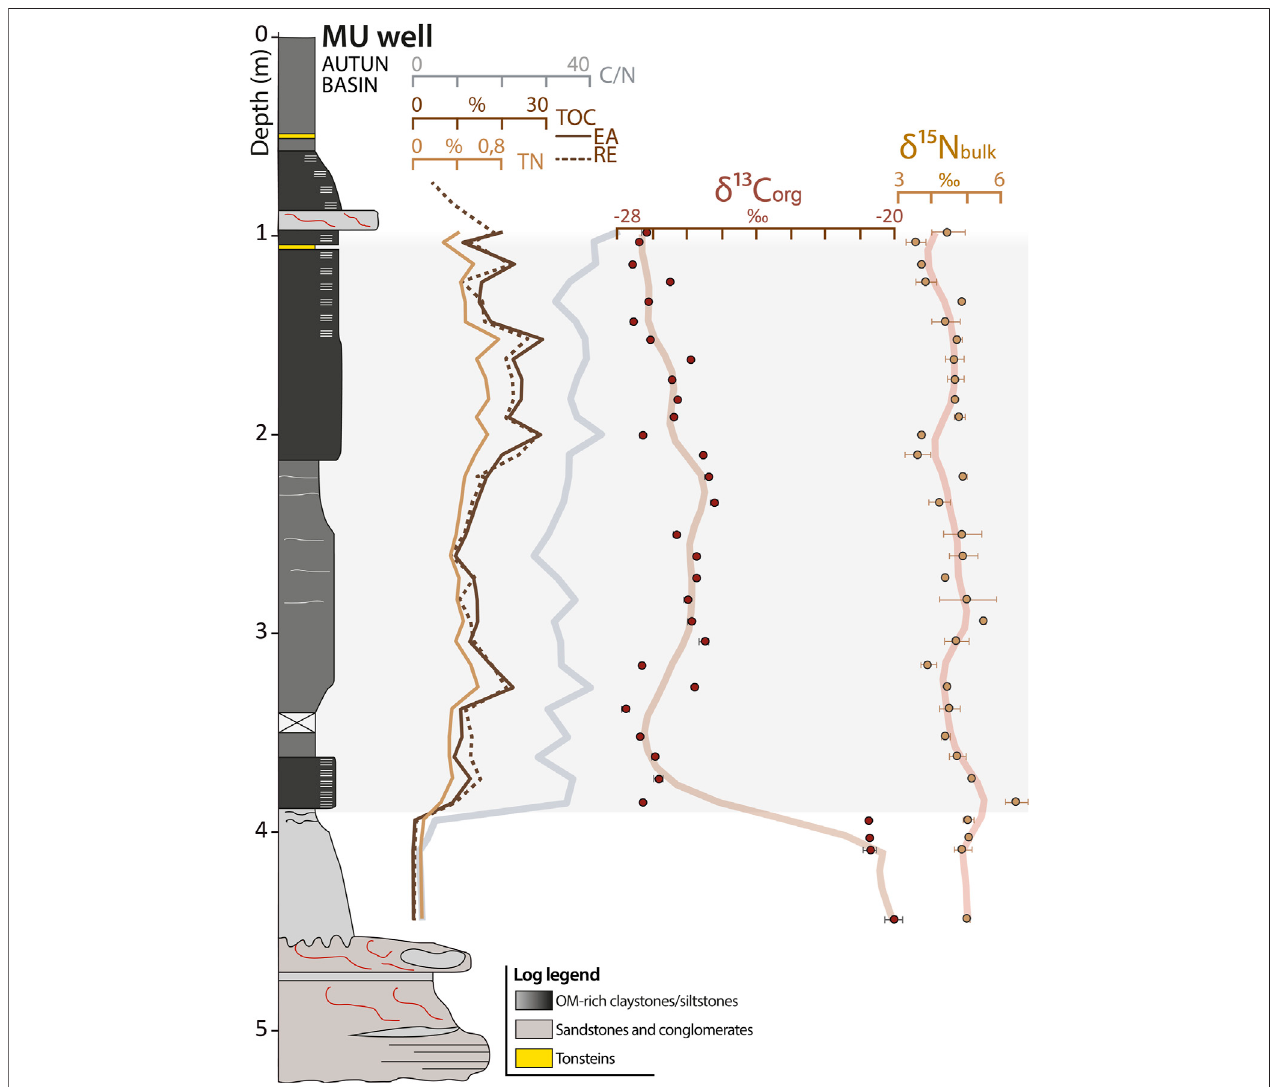
FIGURE 5 | Sedimentary section of the MU core (Autun Basin) and organic signal evolution (total organic carbon TOC, total nitrogen TN, C/N atomic ratio, δ 13 C org and δ 15 N bulk variations). The log caption is displayed on Figure 2 . RE, Rock-Eval